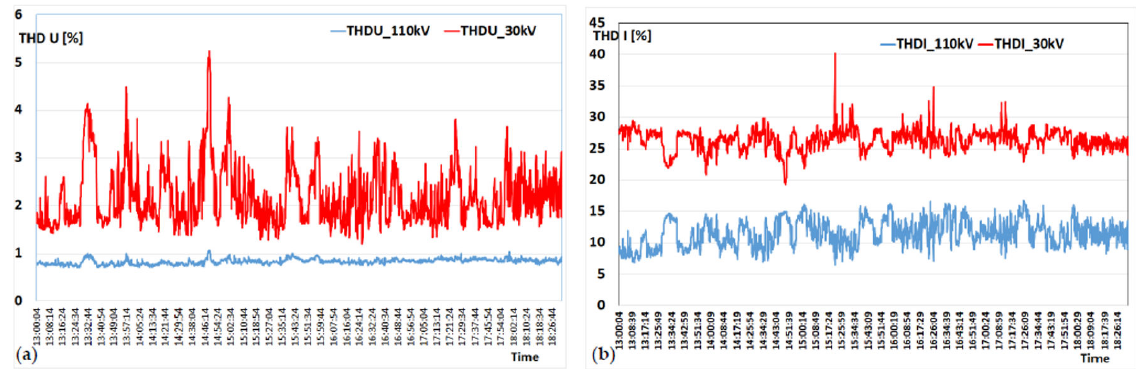
Figure 4. Changes THDU ( a ) and THDI ( b ) recorded at point A (110 kV) and point A (cid:48) (30 kV). The degree of deformation of the current and voltage curve is influenced by the value of the short-circuit power of the network at point A (S cc = 1653 MVA) and point A (cid:48) (S cc = 71 MVA) in relation to the power consumed by the traction substation. The main cause of voltage distortion in MPS is the nature of devices installed on the traction substation, i.e., traction rectifiers. Currently, mainly 12-pulse rectifiers are installed, while in older solutions 6-pulse rectifiers are